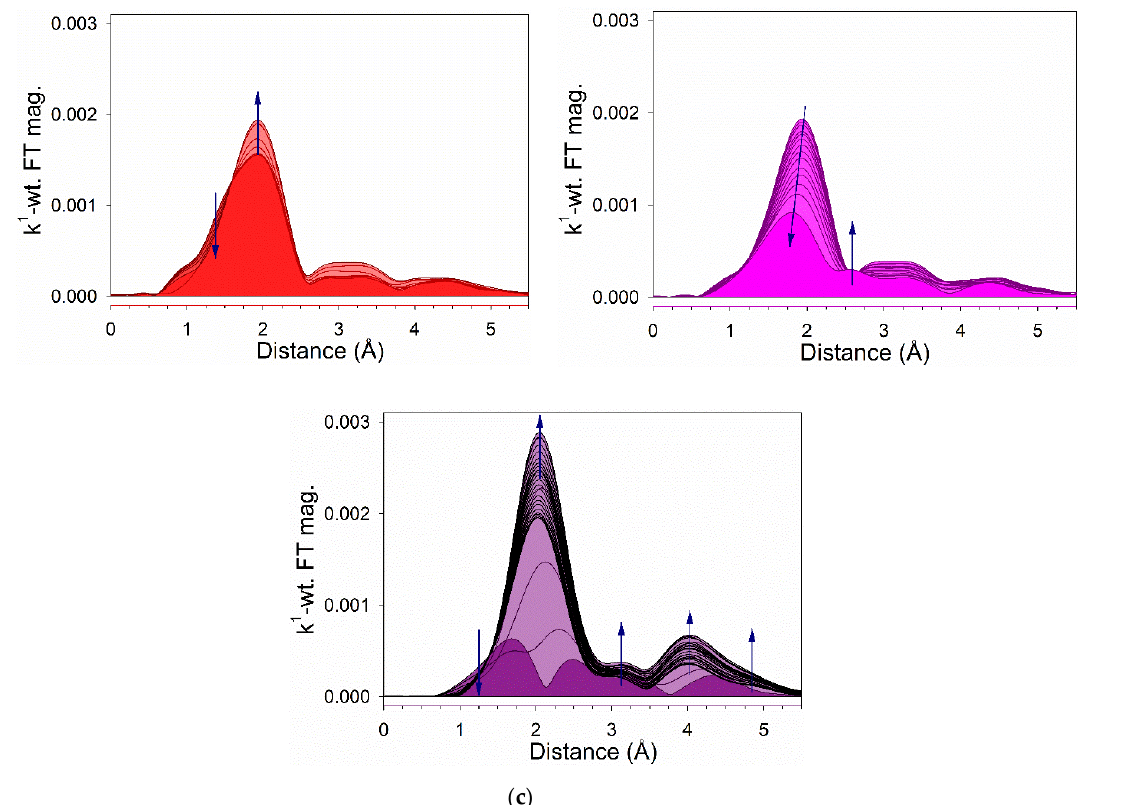
Figure 15. TPR-EXAFS profiles for the different temperature regions of ( a ) calcined 12% Co/SiO 2 from cobalt chloride, ( b ) uncalcined 12% Co/SiO 2 from cobalt chloride, and ( c ) uncalcined 0.5% Pt-12% Co/SiO 2 from cobalt chloride.